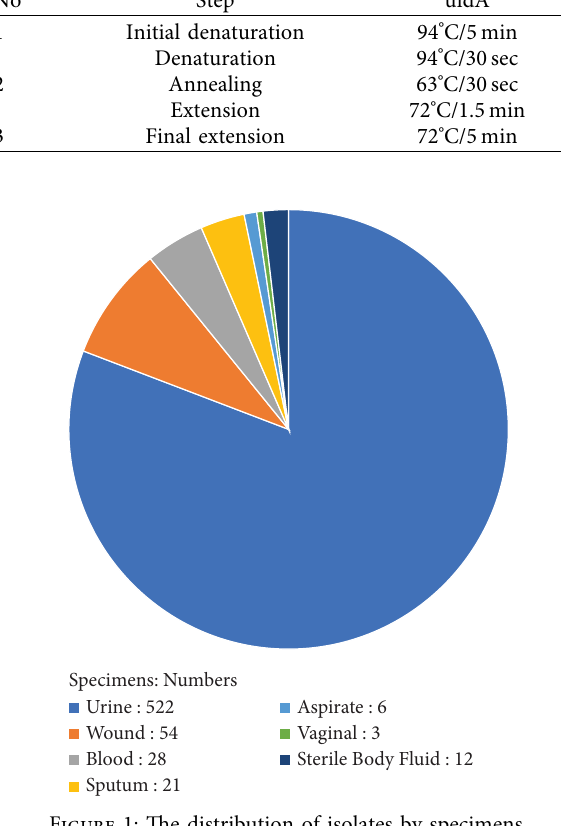
Figure 1: Te distribution of isolates by